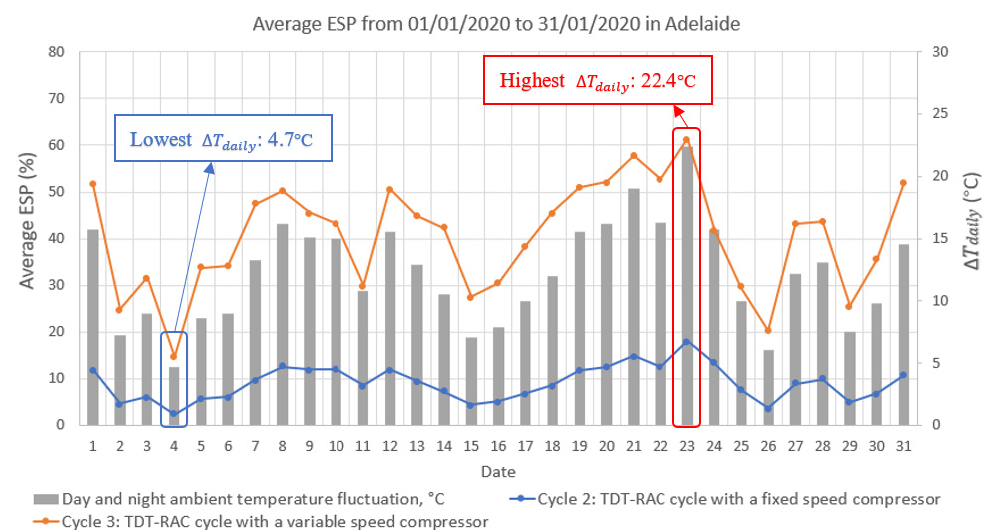
Figure 12. Results of the case study: the average ESP over 6 h of each day in January 2021, Adelaide (Kent Town).